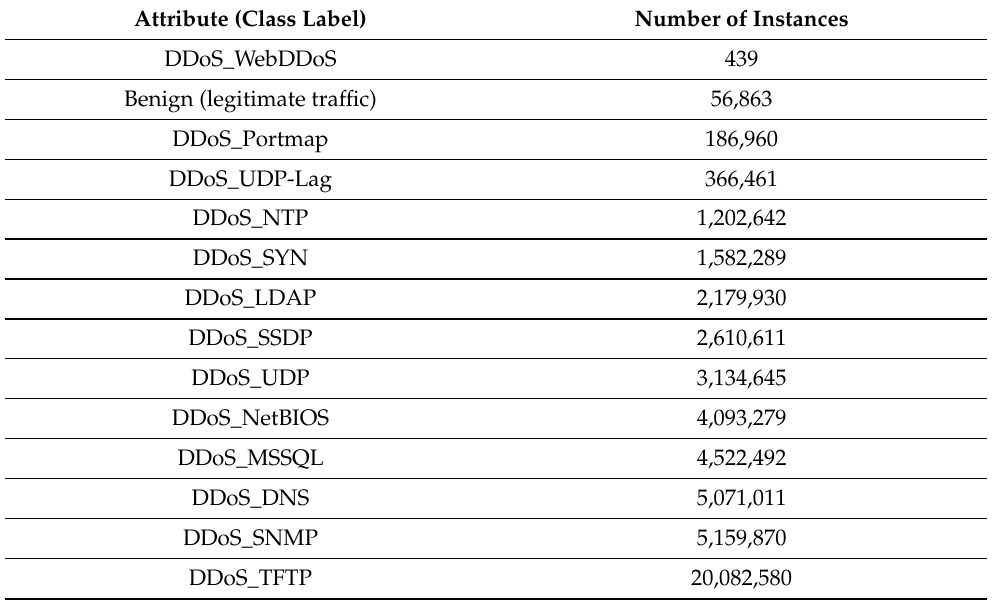
Table 1. Number of instances in the CICDDoS2019